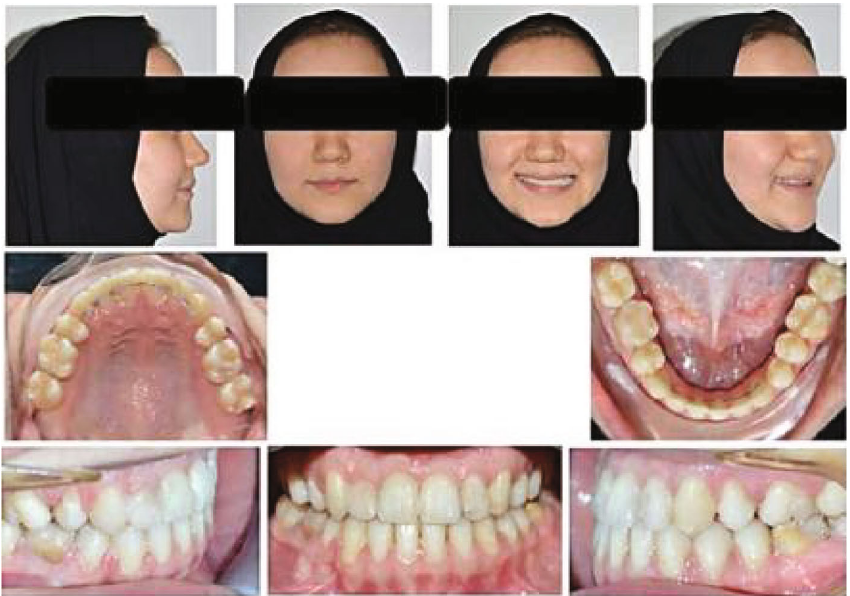
Figure 5: Posttreatment photographs of the